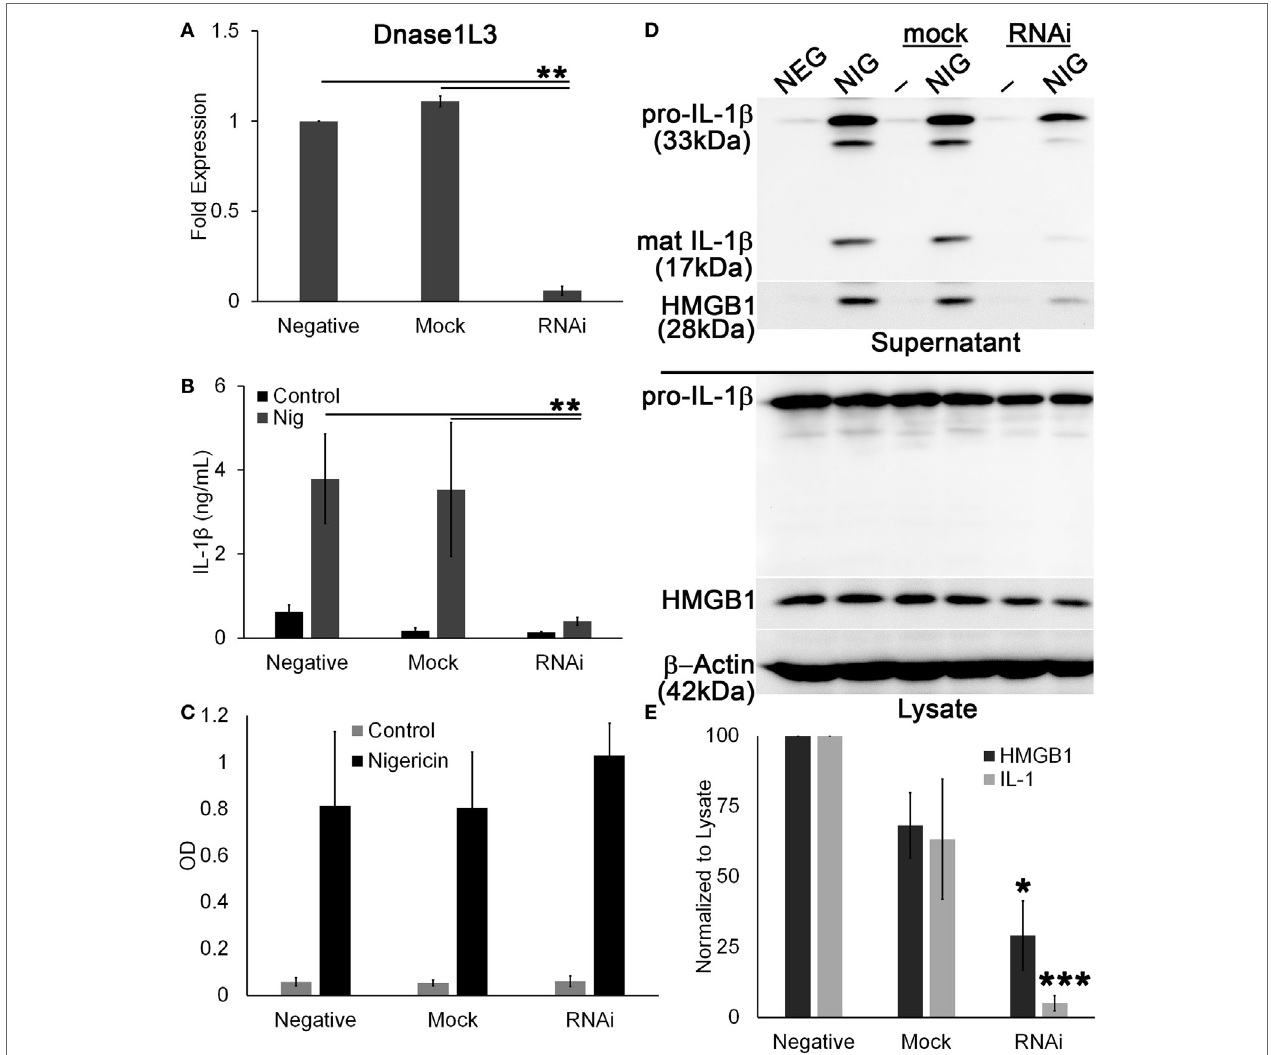
FigUre 7 | ablation of Dnase1l3 blocks il-1 β release . THP1 cells were transfected with nothing, mock, or Dnase1L3 siRNA, then phorbol 12-myristate 13-acetate (PMA) differentiated for 2 days, and treated with 20 µM nigericin for 30 min. (a) Cells were then lysed in TriZOL, and total RNA was extracted from PMA-differentiated THP1 cells transfected with nothing, mock, or Dnase1L3 siRNA. Dnase1L3 expression was measured by qRT-PCR, using GAPDH as a control. Supernatants were used for ELISA (B) , LDH assay (c) or trichloroacetic acid precipitated (D) . Supernatants assayed for TNF α release were collected after PMA differentiation, but prior to nigericin treatment. Maximum TNF α release was always from non-transfected THP1 cells and was an average of 1.2 ng/mL. OD values for LDH assay represent OD 490 –OD 680 . (D) Cells were lysed in SDS sample buffer. Proteins were resolved by SDS-PAGE and transferred to nitrocellulose. High- mobility group box 1 protein (HMGB1), IL-1 β , and β -actin were detected by western blot. (e) The levels of mature IL-1 β in the supernatant were ratioed to pro-IL-1 β levels in the cell lysates, or levels of secreted HMGB1 were ratioed to HMGB1 in the lysate, and expressed as a percentage of control, nigericin-treated cells. Graphs are mean ± SEM of 3 (a–c) or 12 (e) independent experiments, and immunoblots are representative of 12 independent experiments. * p < 0.05, ** p < 0.01, *** p < 0.001, Dnase1L3 RNA interference (RNAi) compared to mock or